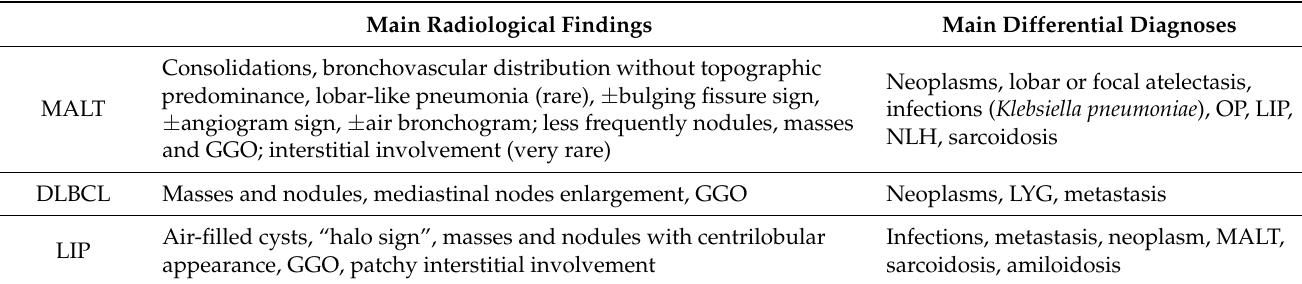
Table 1. Summary table of main radiological findings and differential